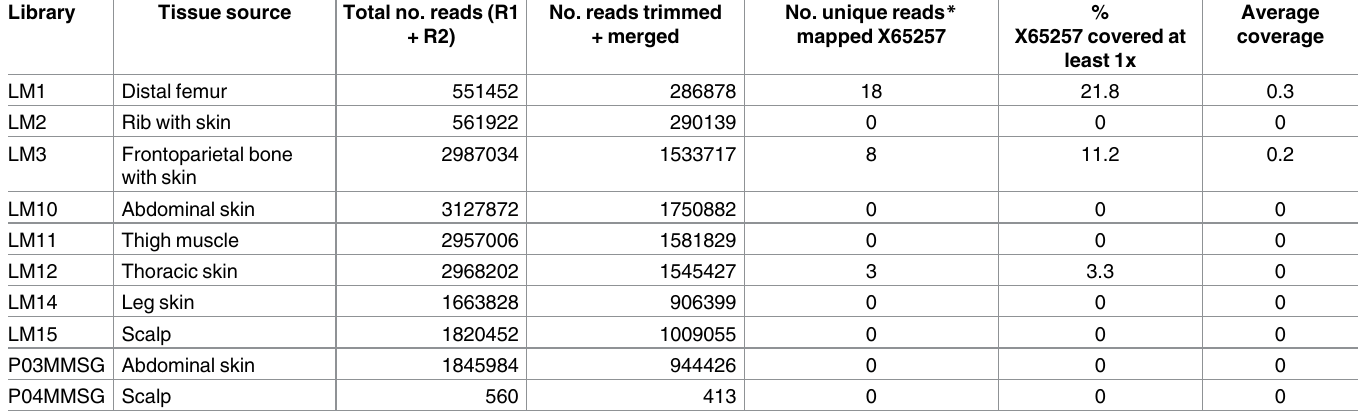
Table 1. HBV reads identified in shotgun sequencing results from various NASD24samples.